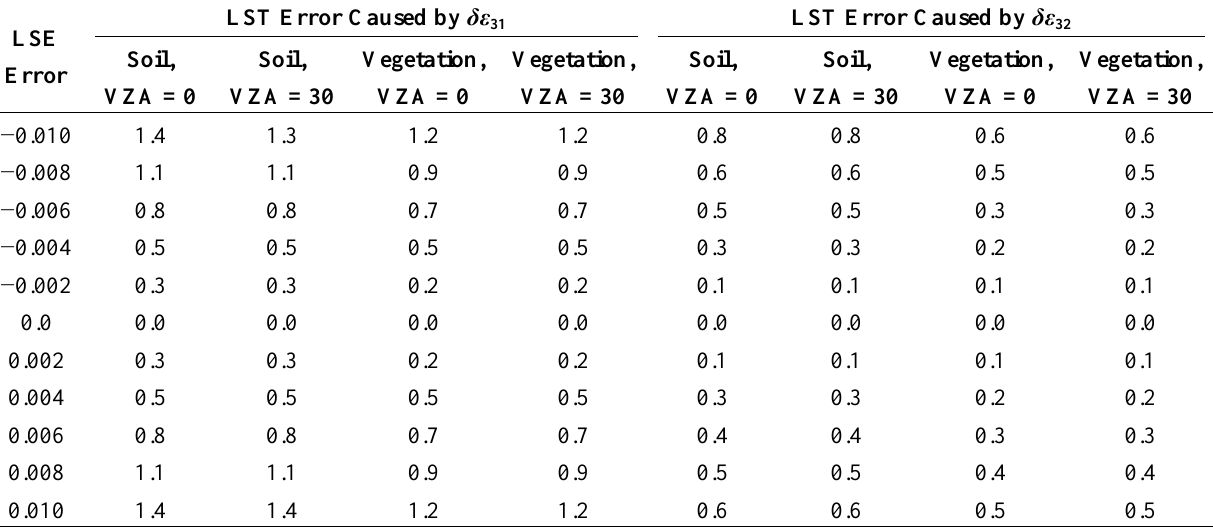
Table 6. Land surface temperature (LST) error caused by errors in the LSEs of MODIS channels 31 and 32 for radiosonde profile BG0314.